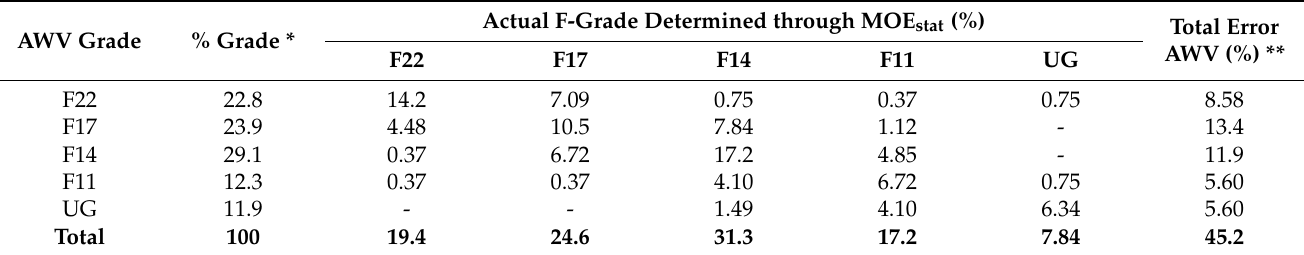
Table 5. Classification of boards via AWV and relative error. Board grades are as described in Table 4. Actual F-Grade Determined through MOE stat (%) AWV Grade % Grade *